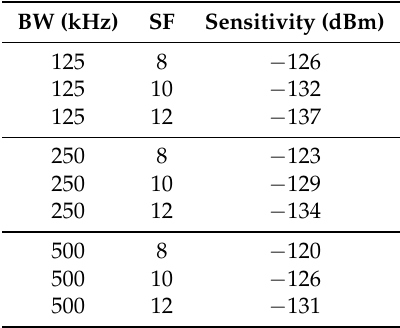
Table 4. Sensitivity values depending on BW and SF, with CR =